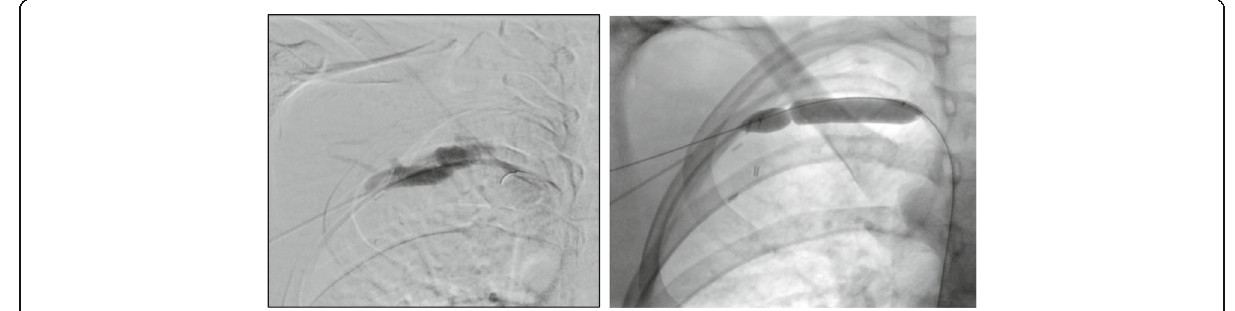
Fig. 3 Venogram post rib resection confirming stenosis in the axillo-subclavian vein and balloon angioplasty